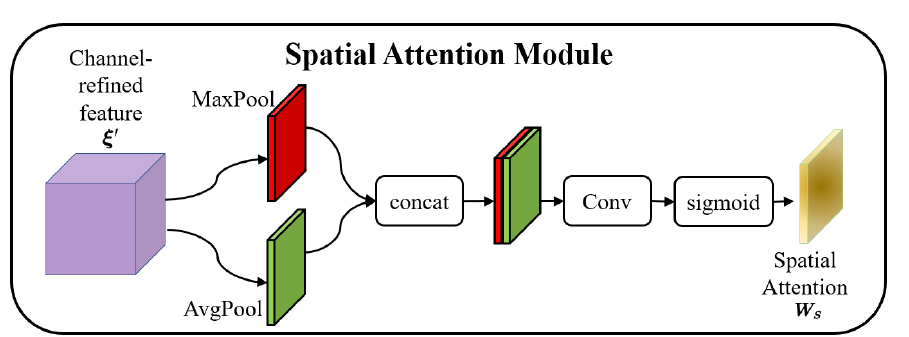
Figure 7. Diagram of spatial attention module.